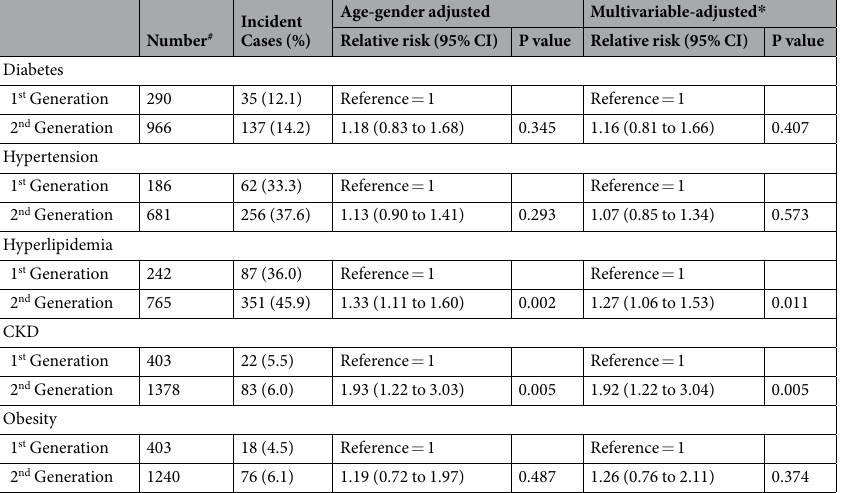
Table 4. Association between generation and incidence of CVD related conditions. * Adjusted for age, gender, obesity, low SES (primary or lower education, and individual monthly income < SGD2000), smoking, alcohol, use of anti-diabetic, anti-hypertensive and anti-cholesterol medications, CVD and mutually for the other CVD related conditions at baseline. # Number at risk varied depending on outcome (e.g. only 867 participants did not have hypertension at baseline and were at risk of incident hypertension). Bolded values indicate statistically significant results. CVD = cardio vascular disease; CKD = chronic kidney disease; SES = socioeconomic